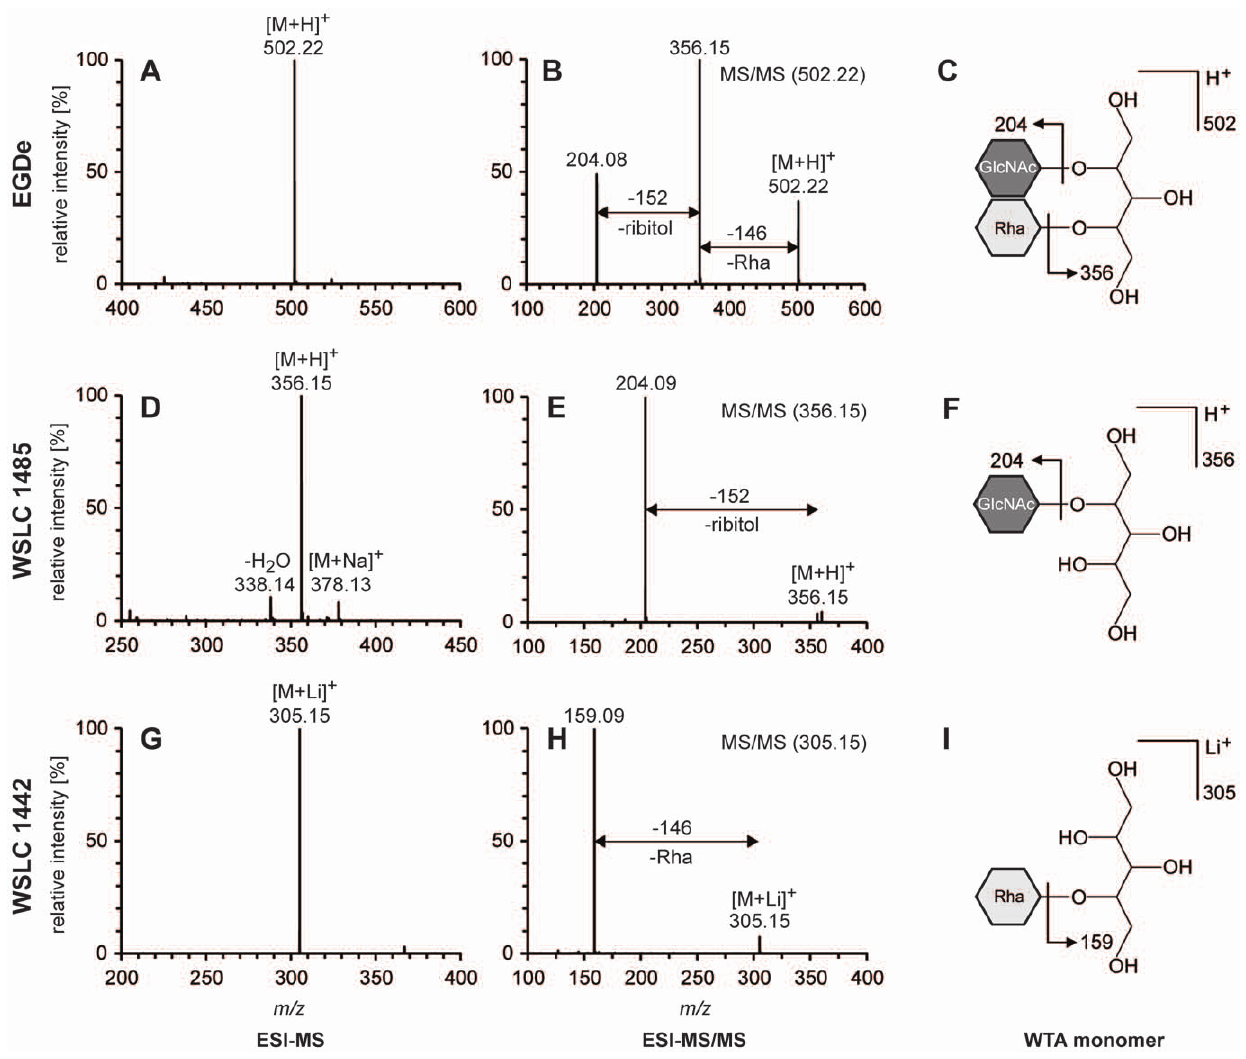
Figure 1. ESI-MS/MS analysis of WTA monomers of L.monocytogenes strains EGDe, WSLC 1485, and WSLC 1442. Left ( A, D, G ): Positive ion spectra (ESI-MS) of WTA monomers. Middle ( B, E, H ): ESI-MS/MS of the [M + H] + ion (B) at m/z 502.22 of WTA monomer EGDe, (E) at m/z 356.15 of WTA monomer 1485, and the [M + Li] + ion (H) at m/z 305.15 of WTA monomer 1442. Right ( C, F, I ): Schematic structures and side chain fragmentation of corresponding WTA monomers. Peak labels show the measured m/z values. Arrows denote WTA fragmentation.